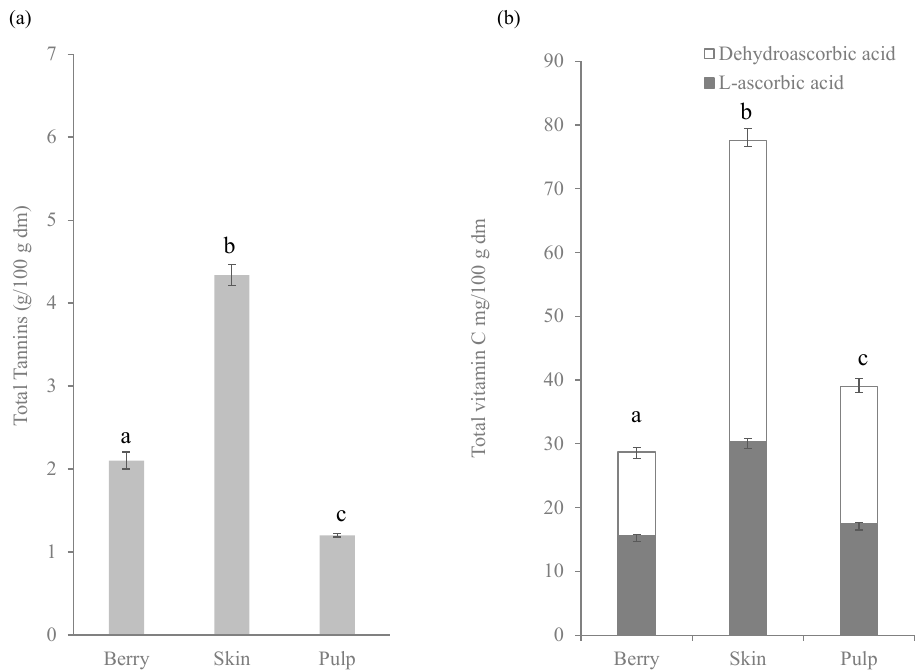
Figure 2. Concentration (g/100 g d.m.) of total tannins ( a ) and (mg/100 g d.m.) of total vitamin C ( b ) in berries, skin and pulp of Windsor blueberry (means and standard deviations). Values with different superscript letters are significantly different, p = 0.01.